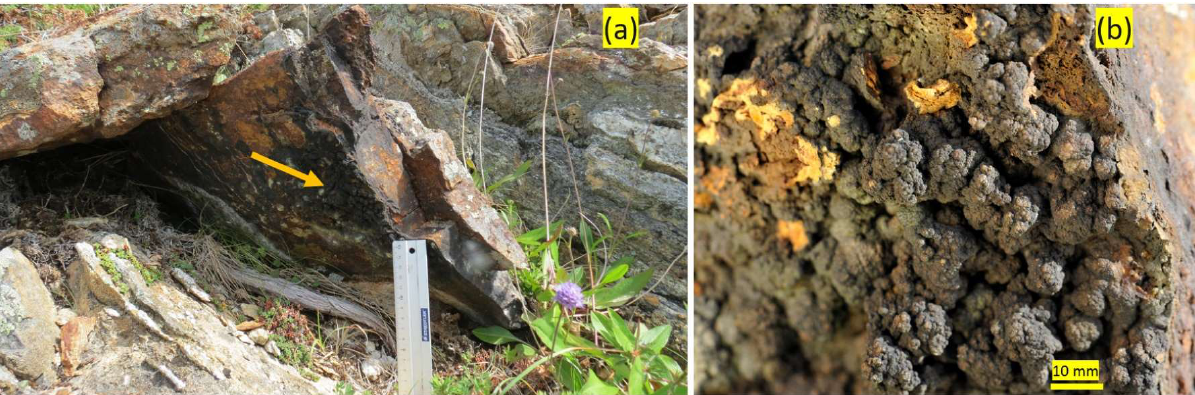
Figure 3. The sampling site at Valen ( a ) with a dark crust of jarosite on the right stone (arrow) along with a 15 cm ruler. Details of the jarosite pointed by the arrow is shown in ( b ).